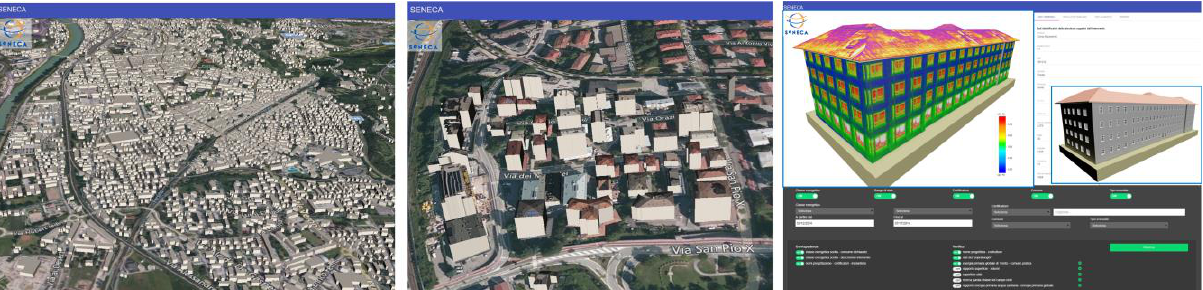
Figure 7. The current SENECA platform interface viewed at urban scale (left), neighborhood scale (middle) and building scale